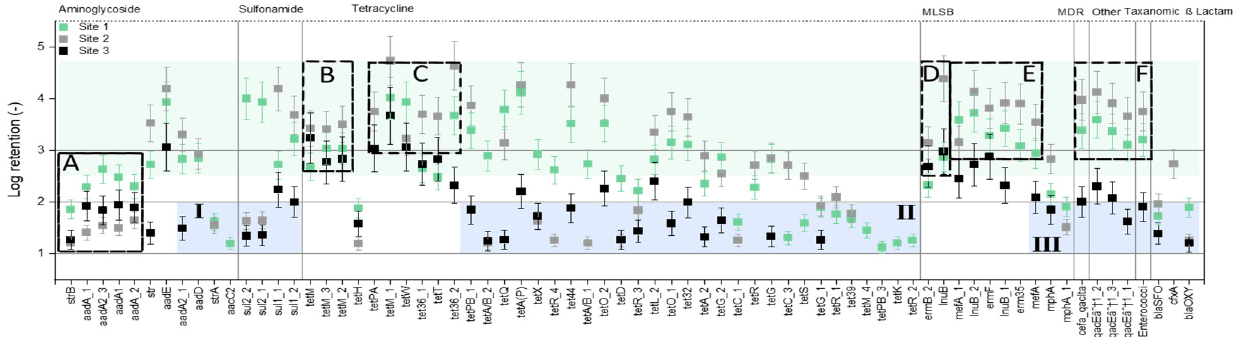
Figure 3. Log retention values (LRVs) of individual ARGs of pig manure and digestate samples of sampling sites 1, 2, and 3. Zones (A), (B), and (D) were enriched in raw samples of all the sampling sites; (C), (E), and (F) were enriched in the raw samples of sites 1 and 2 but not in the raw digestate sample of site 3; Zones I, II, and III denoted the absolute ARG copy numbers ≤ 10 3 /100 µ L in the raw samples of all sampling